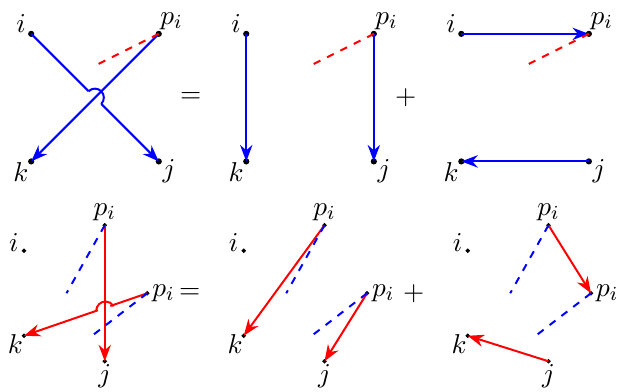
Figure 3 . Schouten identities w.r.t. LG indices (3.1) are again equivalent to untying crossings of edges anchored to the spin and momentum vertices associated with the same